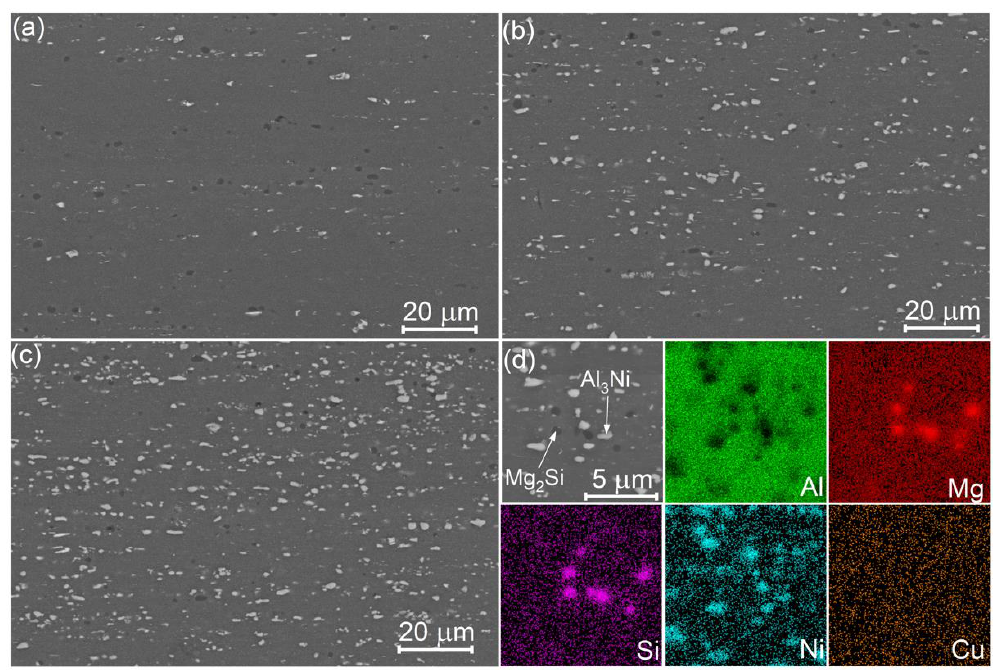
Figure 6. SEM images of cold rolled sheets after final 20 min annealing at 480 °C for the ( a ) alloy 1 (Al-1.2Mg-0.7Si-1.0Cu-0.5Ni), ( b ) alloy 2 (Al-1.2Mg-0.7Si-1.0Cu-2Ni), and ( c , d ) alloy 3 (Al-1.2Mg-0.7Si-1.0Cu-4Ni) with corresponded SEM-EDS maps.